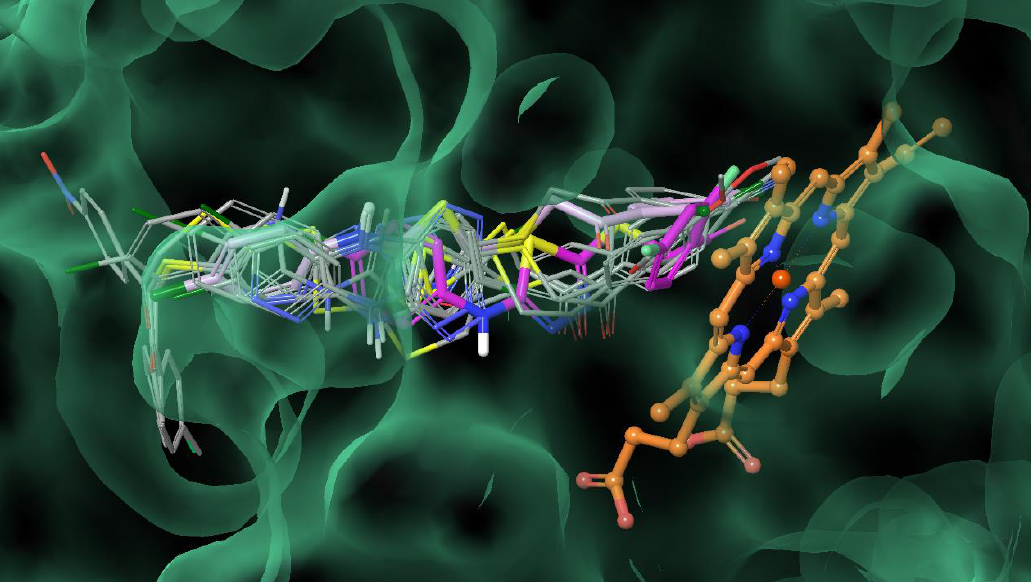
Figure 3. The superimposition of all compounds ( 3a – 3l ) in the active region of 14- α -sterol demethylase (Protein Data Bank (PDB) code: 5FSA). The heme molecule is colored orange, while compounds 3k and 3l are colored purple and pink, respectively.